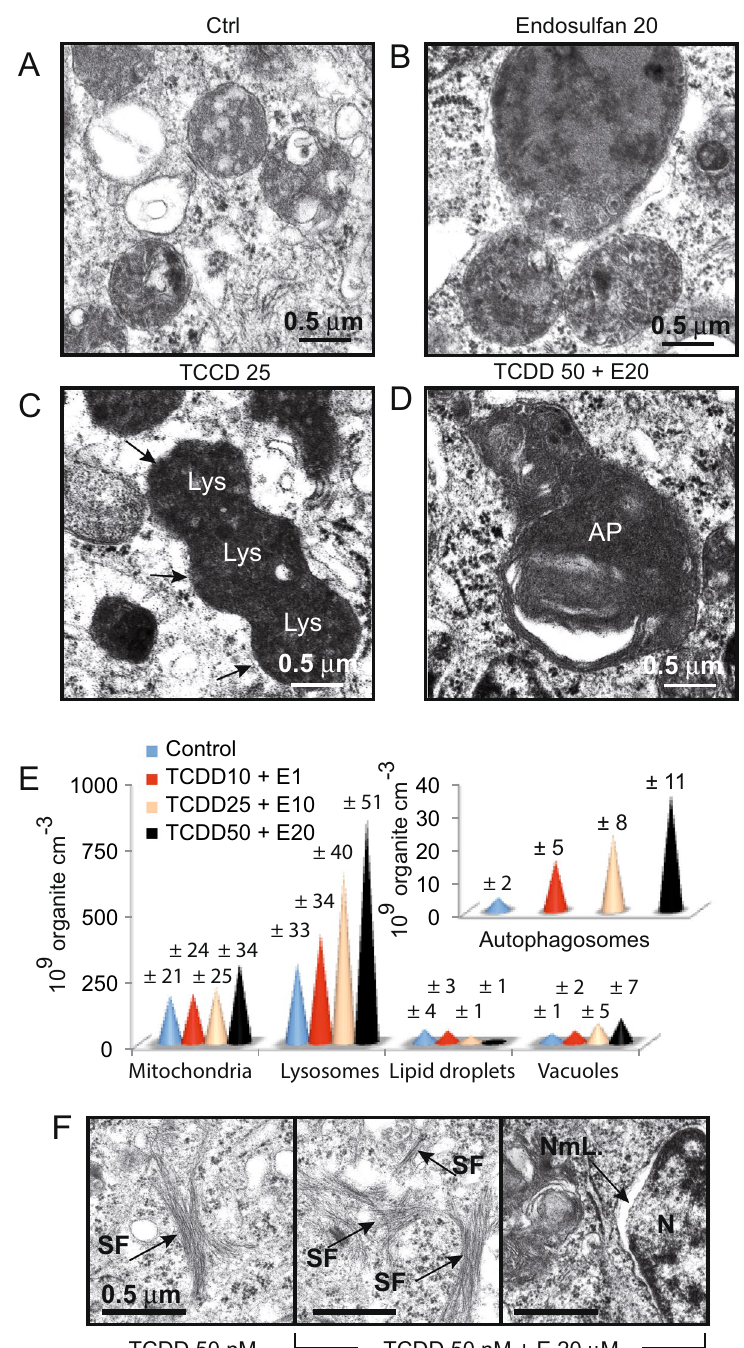
Figure 7. Morphology of the lysosomes and details of the cytoplasm in cells treated with a cocktail of polluants. ( A – D ) Caco-2 cells were treated for 24 h with 20 µ M endosulfan, 50 nM TCDD or 50 nM TCDD combined with 20 μ M endosulfan and observed under transmission electron microscopy. Typical lysosomes are shown in control ( A ) When cells are treated with α -E (20 μ M) alone, the lysosomes appeared swollen ( B ) whereas with TCDD alone (50 nm) the lysomes become electron dense and seem to fuse to each other ( C ). When the sample has been treated with a cocktail of pollutant, i.e., TCDD 50 nM and α -E (20 μ M), autophagosomes are visible ( D , E ) Relative aboundance of each subcellular compartment estimated from electron microscopy picture and counted. The mitochondria, lysosomes, lipid droplets and vacuoles are counted on one side and the autophagosomes upper left pannel are counted apart. Statistical analysis calculated from 10 separated experiments and from 5 differents microscopic field (pooled) for each (n = 10). ( F ) Electron microscopy picture of Caco-2 cells treated with 50 nM TCDD alone or a cocktail of TCDD 50 nM + 20 μ M Endosulfan. SF: stress fibers and NmL, nuclear membrane